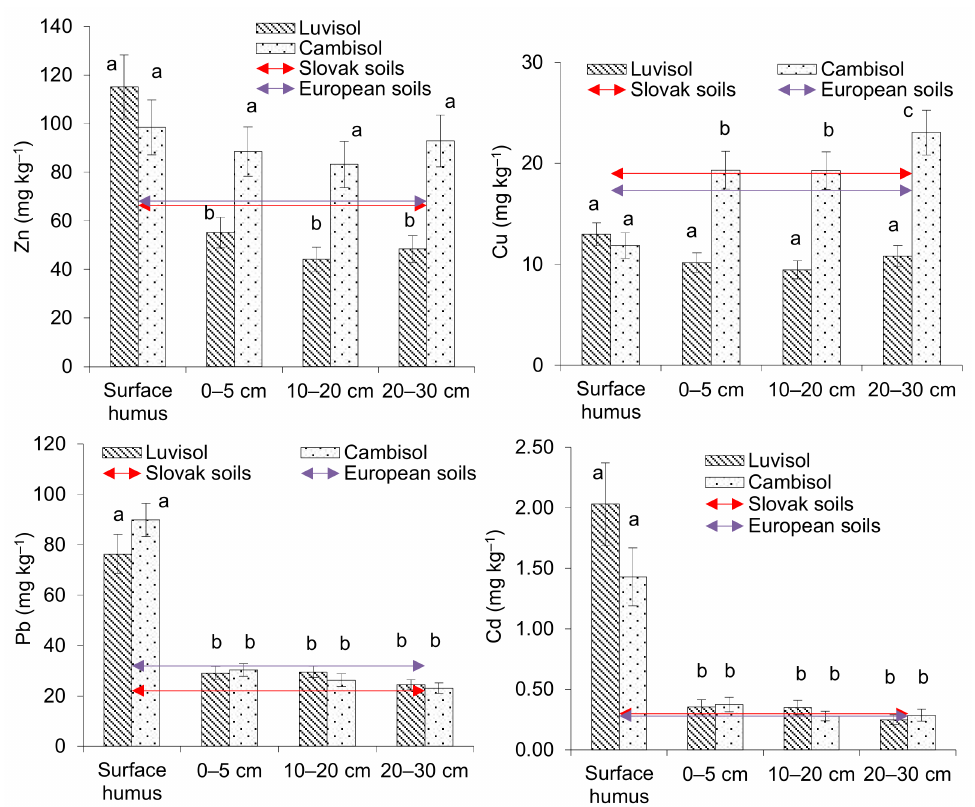
Figure 2. Concentrations of toxic elements in soils ( n = 3). ANOVA, Fisher’s LSD test. Significantly different mean values ( p < 0.05) among soil-unit horizons are indicated by different letters ( a,b,c ). Median values of Slovak soils [43]; Mean values for the topsoil of Europe (Zn 68.1, Cu 17.3, Pb 32, Cd 0.28), after FOREGS 2005